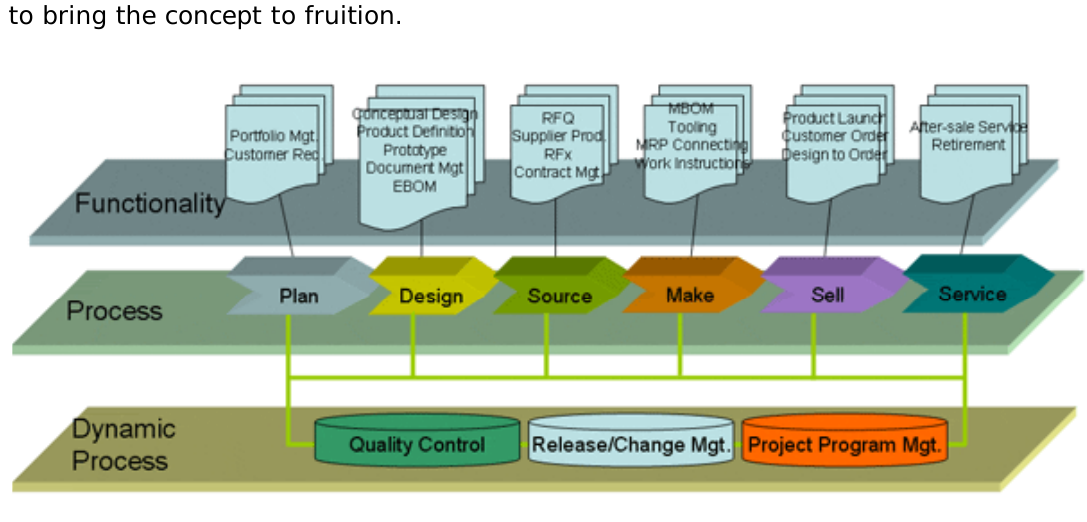
Figure 1. “Structure of PLM System”. Source: Siemens PLM,